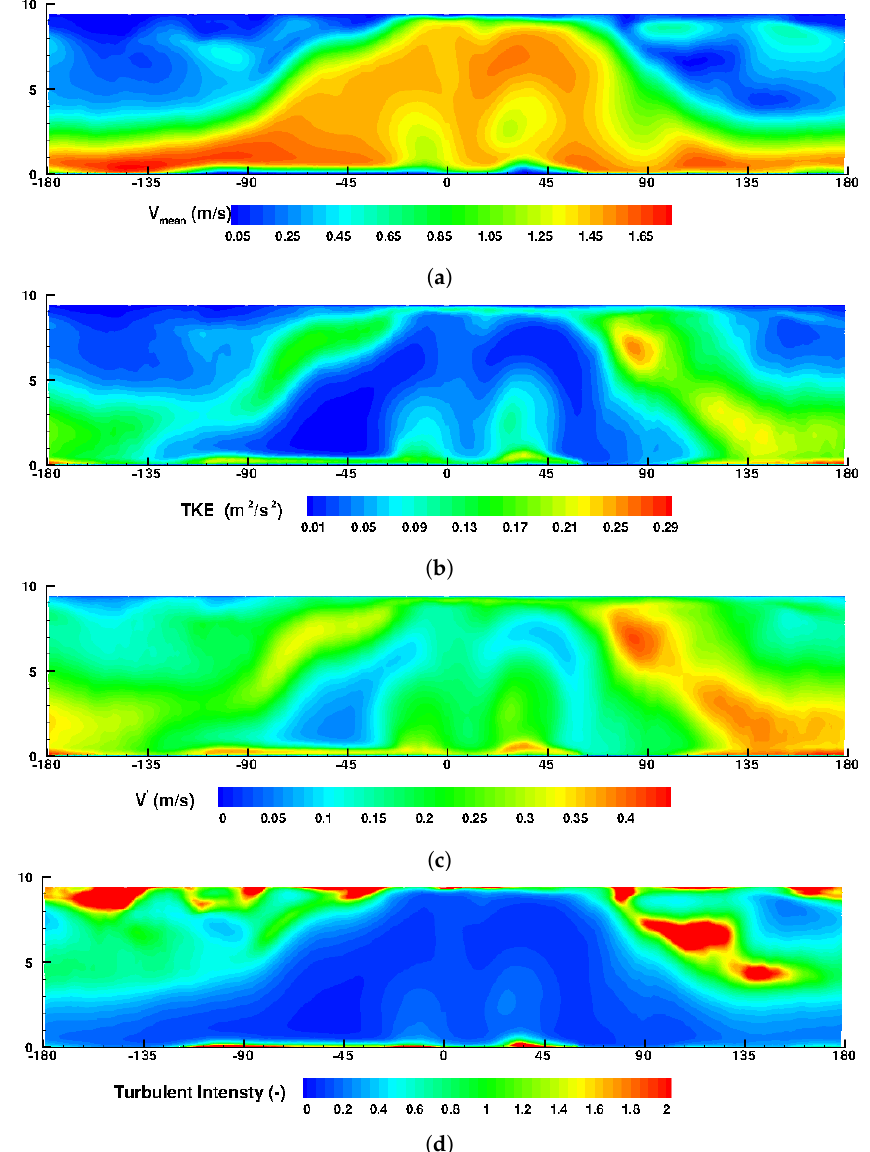
( d ) Figure 19. Turbulence properties from LES (WALE -fine mesh) along the valve curtain: ( a ) absolute mean velocity, ( b ) turbulent kinetic energy, ( c ) turbulent velocity, ( d ) turbulence